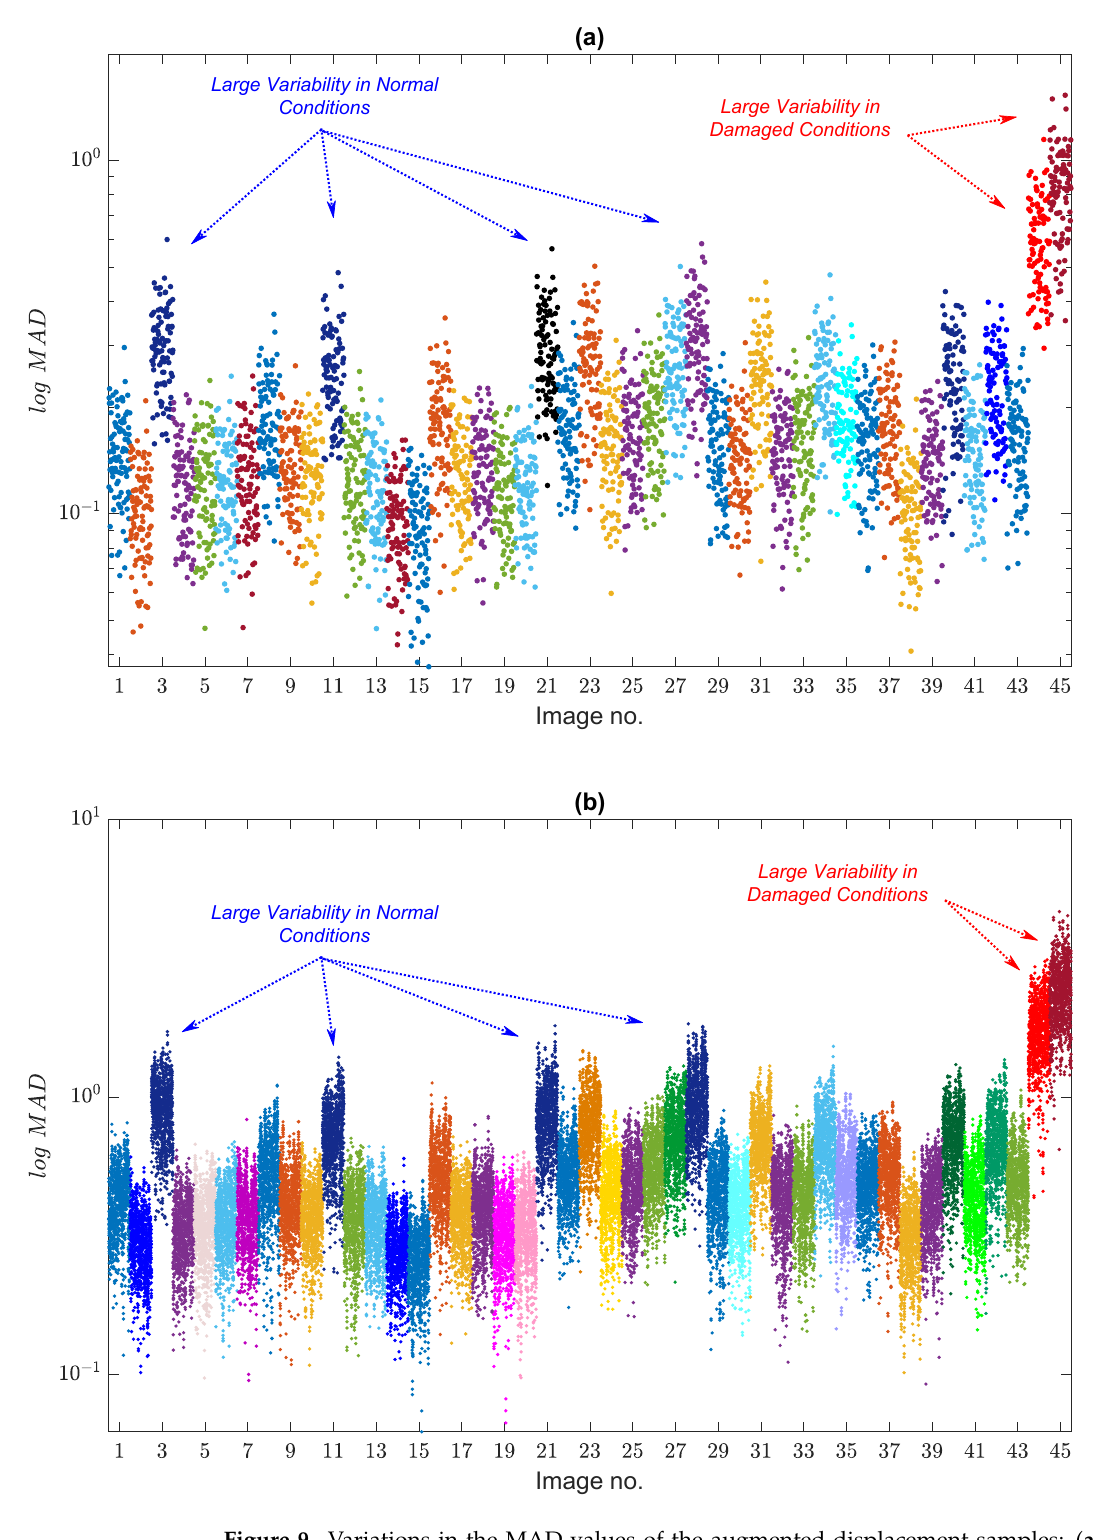
Figure 9. Variations in the MAD values of the augmented displacement samples: ( a ) the HMC sampling, ( b ) the slice sampling.